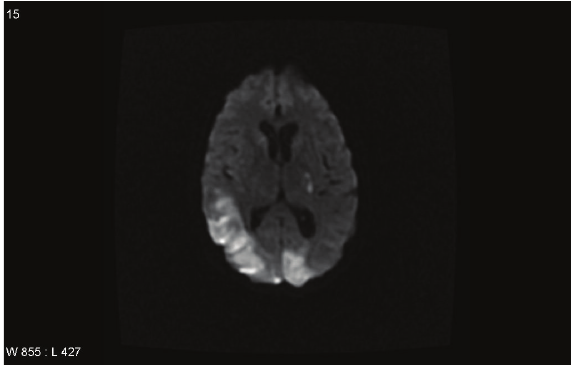
Figure 1: MRI brain on presentation.